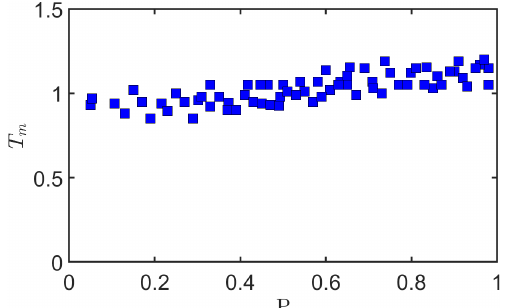
Figure 10. The variation of the scaled effective time T m with